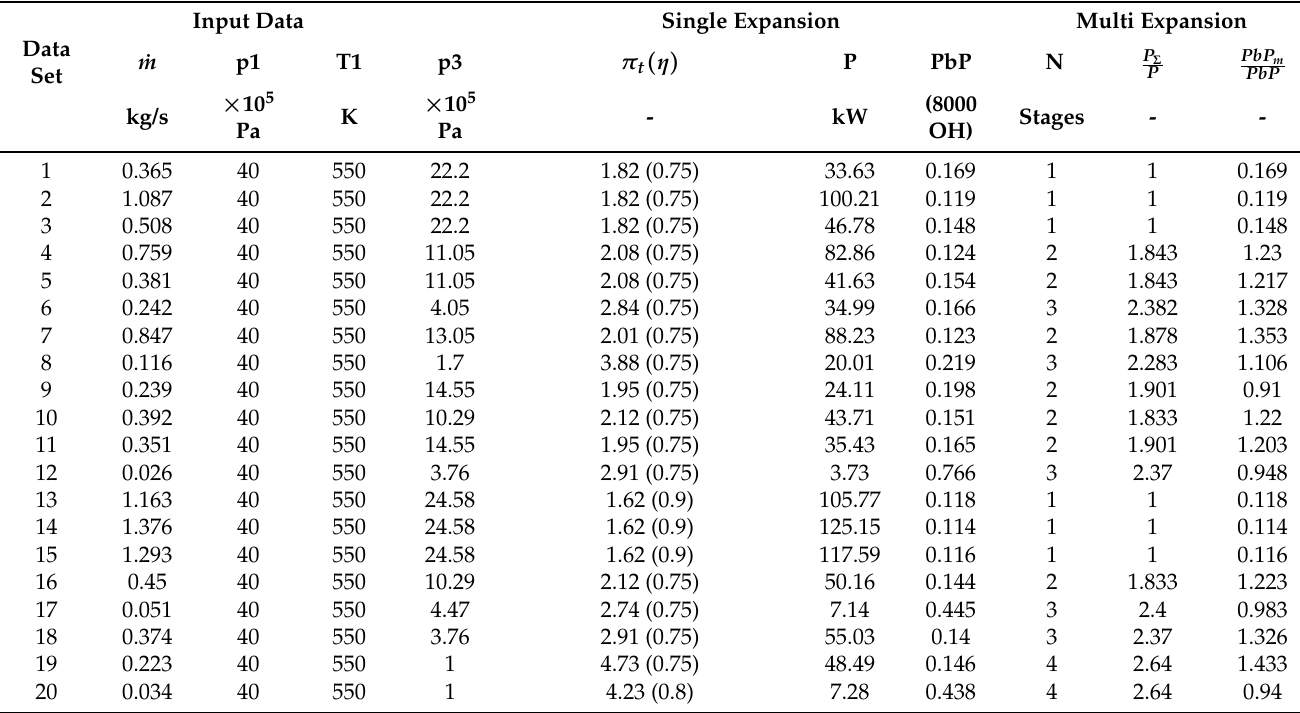
Table A2. Data set from industry steam networks at T1 = 550 K and main results for single and multi expansion. Input Data